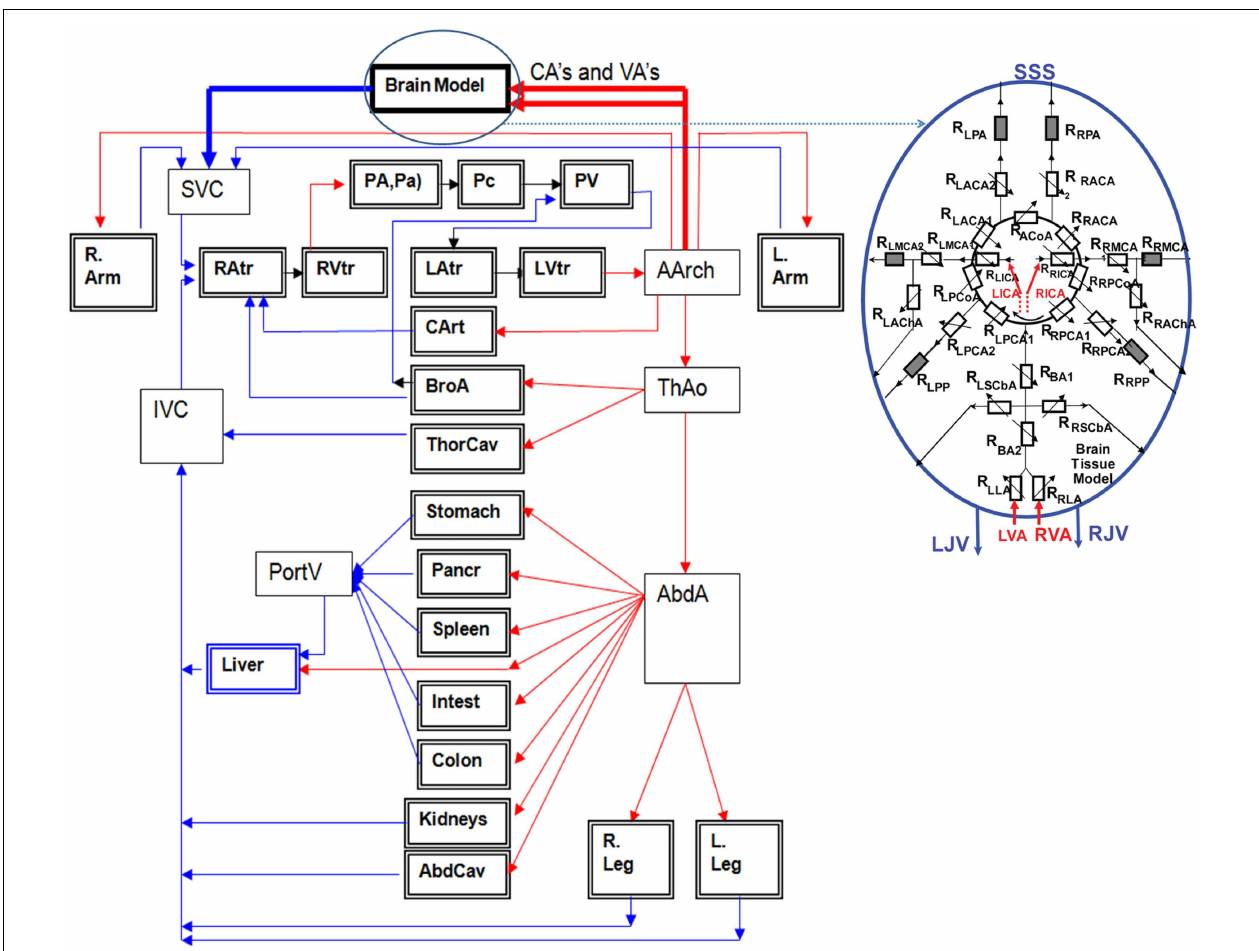
FIGURE 10 |Whole body multi-compartmental human cardiovascular system and the cerebral perfusion (circle ofWillis) models